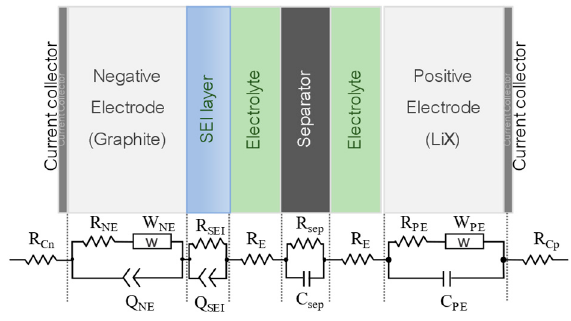
Figure 2. Decomposition of a battery impedance spectrum.